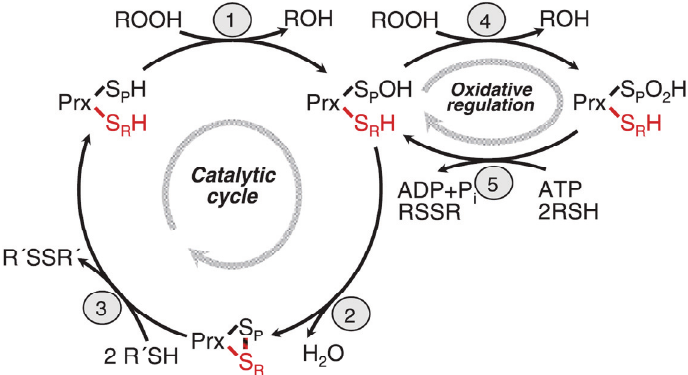
Figure 2. Reaction cycle of eukaryotic 2-Cys peroxidredoxins. Step 1: The peroxidatic cysteine is oxidized to the sulfenic acid and concomitantly substrate (ROOH) is reduced to ROH. Step 2: The sulfenic acid form of the peroxidatic cysteine reacts with the resolving cysteine in the other subunit of the dimer, forming a disulfide bridge and releasing